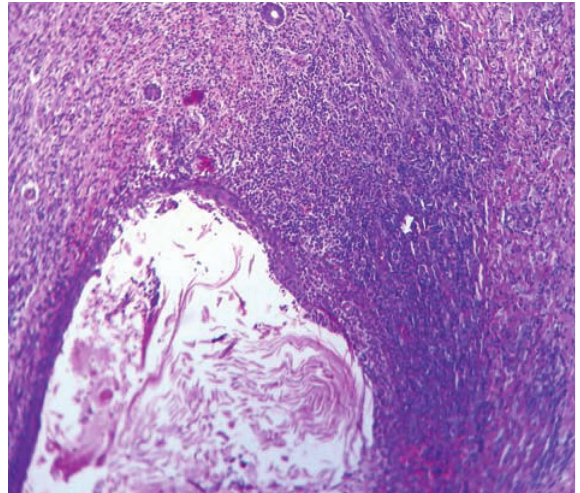
Figure 3: Photomicrograph showing dense mixed inflammatory cell infiltrate in the dermis immediately adjacent to the crater [100x